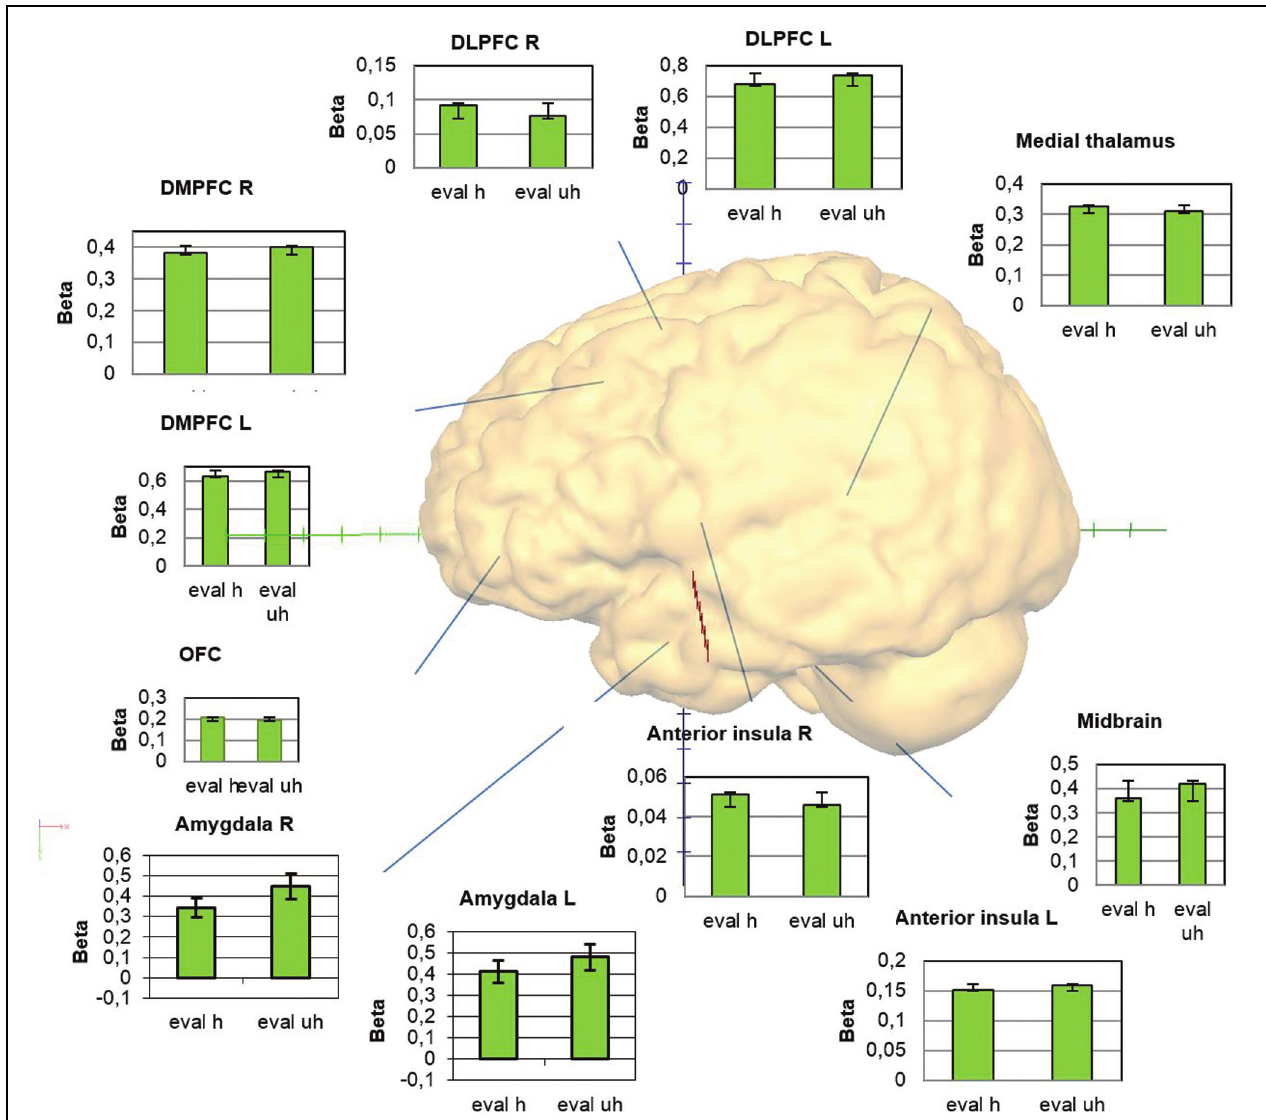
FIGURE 4 | Overview of the activations within the regions of interest providing graphs with the beta weights for the conditions evaluation healthy and